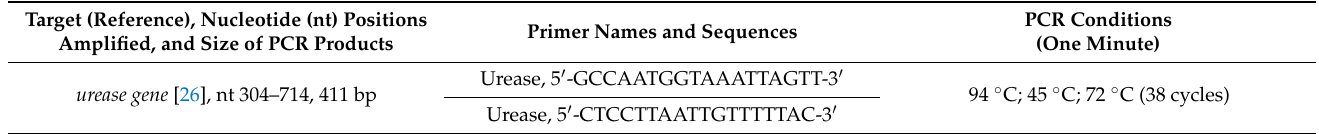
Table 8. The sequence of used primers to determine Urease